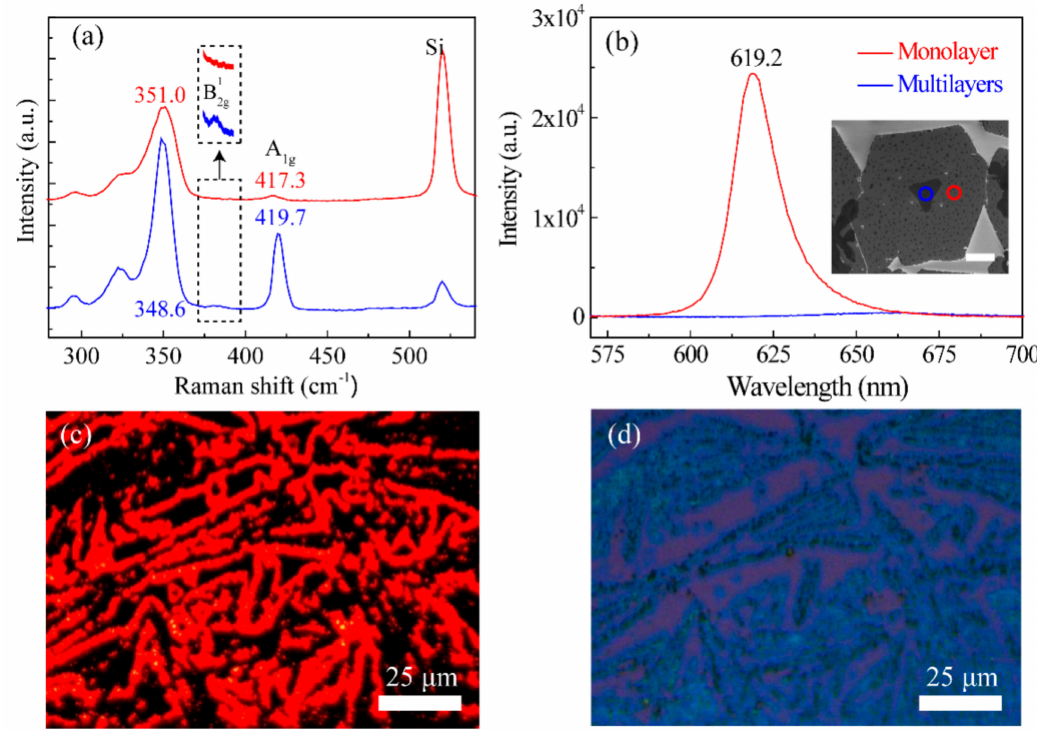
Figure 4. The Raman ( a ) and photoluminescence (PL) spectra ( b ) of the WS 2 monolayer (red line) and multilayers (blue line). Inset in (a) is a detailed illustration of the B 2g1 and A 1g modes. The insert in (b) is an SEM image, and the scale bar represents 5 µ m. ( c ) Photoluminescence (PL) and ( d ) optical microscopy images of WS 2 mono- / multimixed layers taken at the same